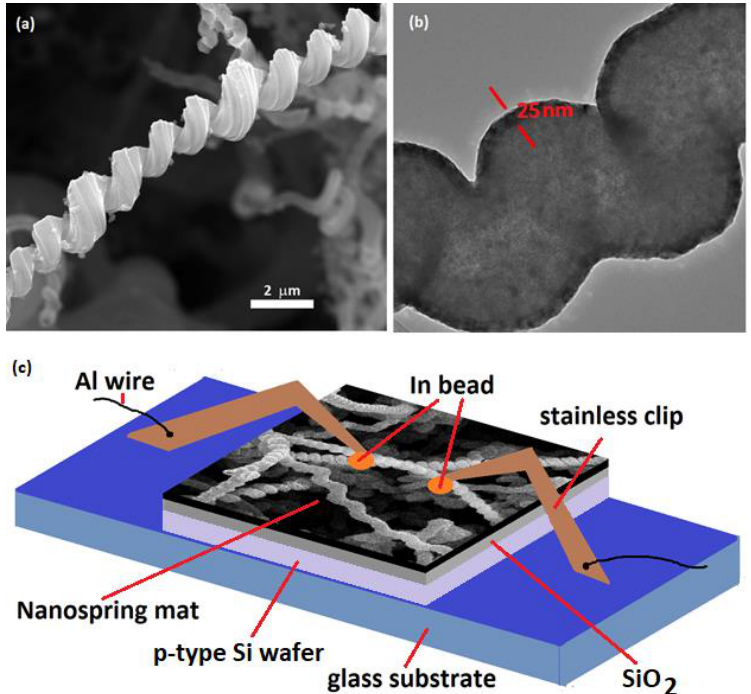
Figure 1. ( a ) Scanning electron microscopy (SEM) image of a bare silica-based nanospring grown for an hour and ( b ) transmission electron microscopy (TEM) image of nanospring coated with 25 nm ZnO; ( c ) schematic of the nanospring sensor mounted on a glass substrate, clipped with malleable indium beads to provide good contact.